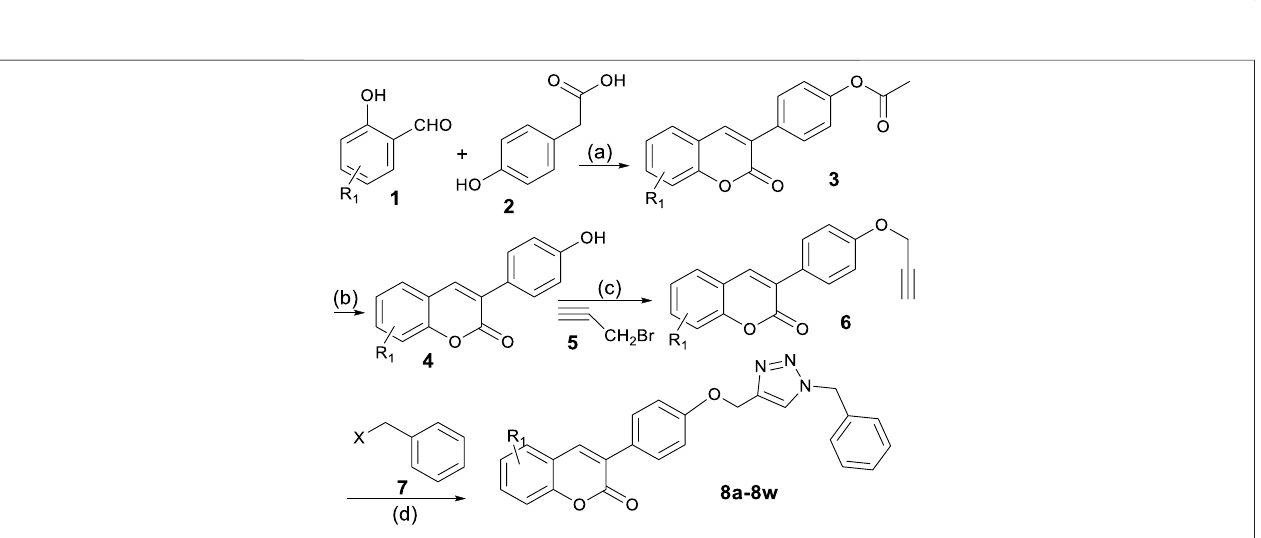
FIGURE 1 | Design strategy for the target compounds based on 3-arylcoumarin derivatives bearing N -benzyl triazole moiety.